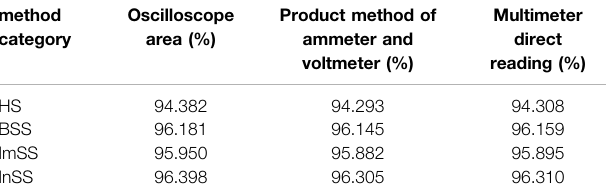
TABLE 4 | Statistics on conversion ef fi ciency. method Oscilloscope category area (%)